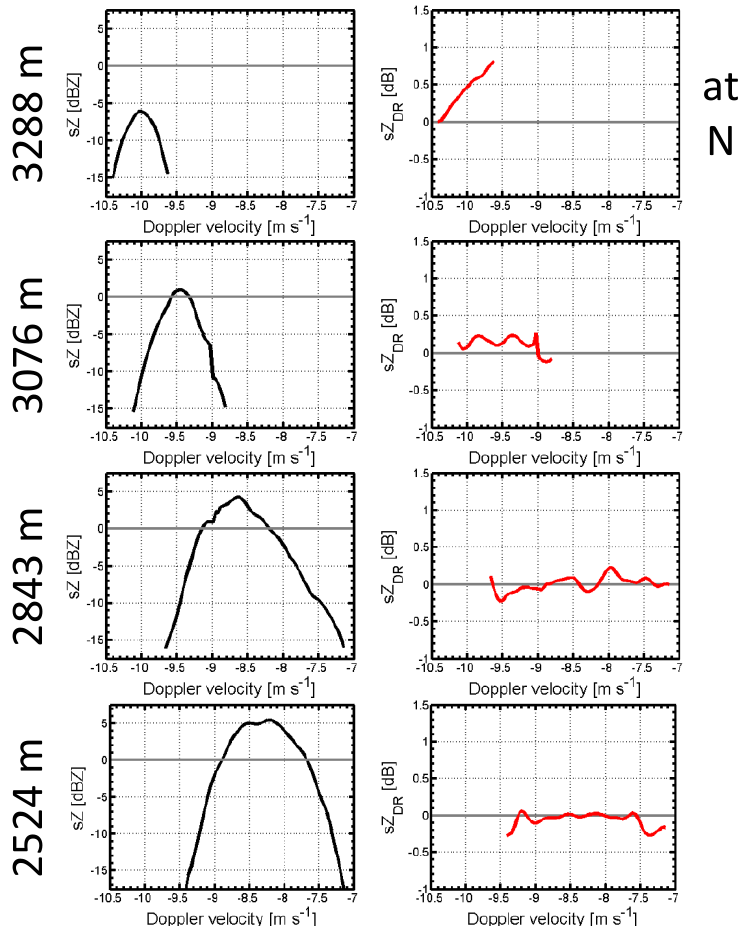
Figure 7. Along the fall streak at 10:12:50UTC rearranged sZ and sZ DR at four different altitudes. The left panel shows Doppler spectra at 3288, 3076, 2843, and 2524m. The right column displays the corresponding spectral differential reflectivity at the same heights. All spectra are at 45 ◦ elevation and averaged over three consecutive time bins ( ∼